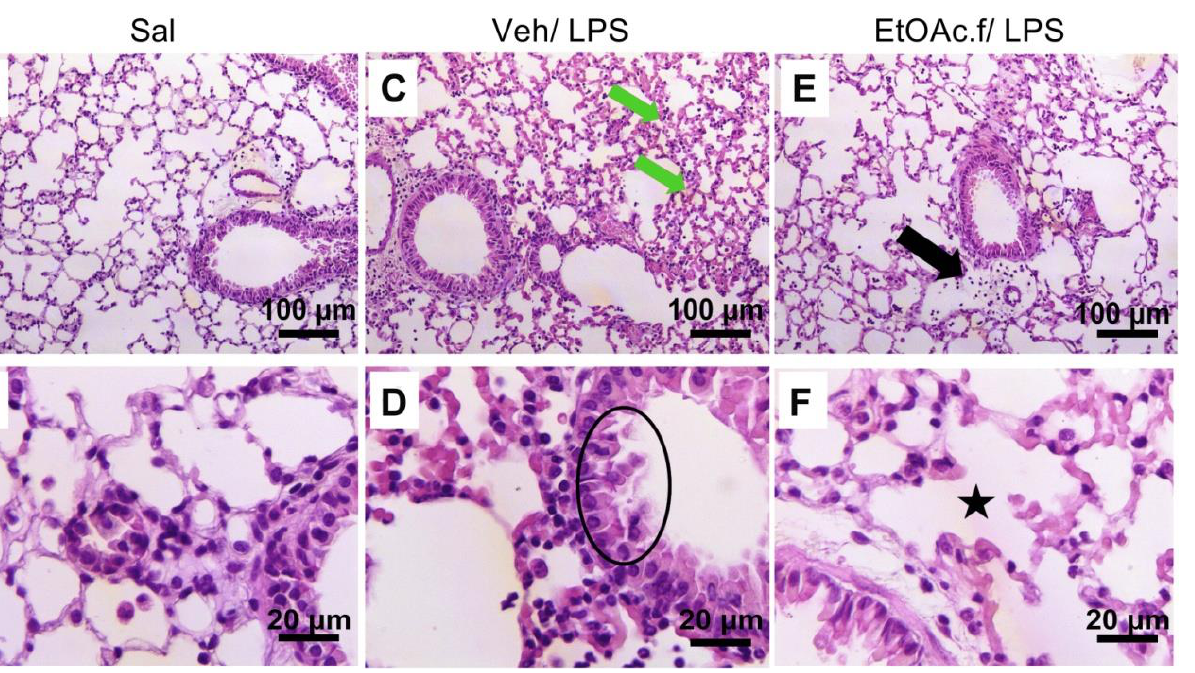
Figure 5. H&E staining of lung tissue sections. Histopathological features of the lung from saline (Sal), vehicle (Veh/LPS), and ethyl acetate fraction (EtOAc.f/LPS) groups. The mice were pretreated with vehicle or EtOAc.f 24 h and 1 h before LPS (10 µ g/40 µ L) challenge. Lung tissue was harvested 24 h after LPS and then processed for H&E staining. ( A , B ) No changes were observed in the Sal group. ( C ) In the Veh/LPS group, hyaline material deposit and ( D ) partially preserved simple epithelium are represented by green arrows and black circle, respectively. ( E ) Discreet inflammatory infiltrate (black arrow) and ( F ) intra alveolar space restored (black star) was evidenced in EtOAc.f/LPS